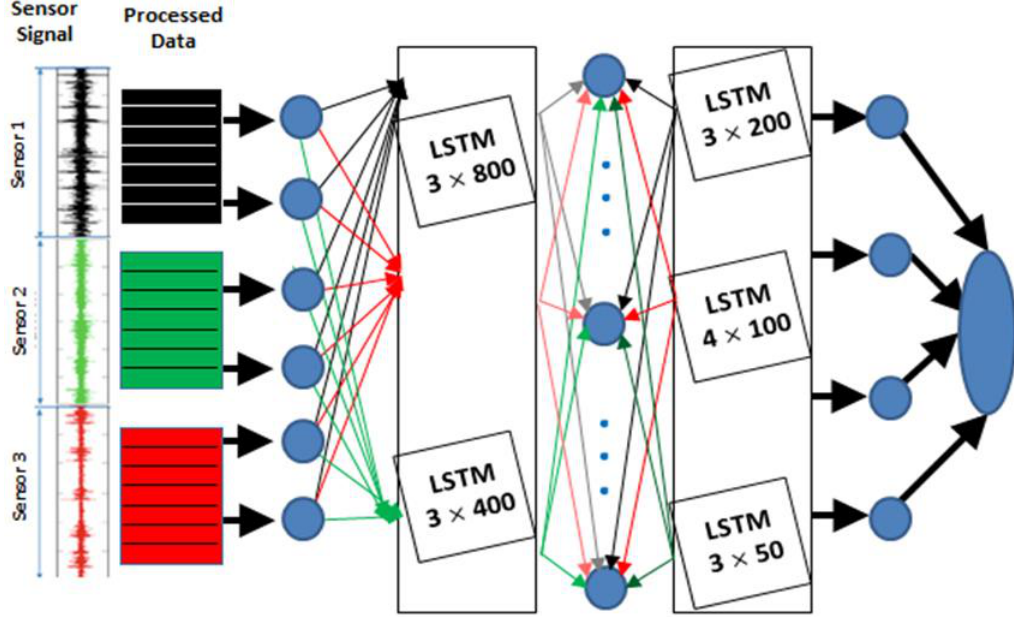
Figure 4. Learning-based network for hand motion classification.